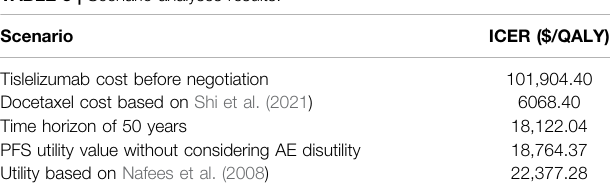
TABLE 3 | Scenario analyses